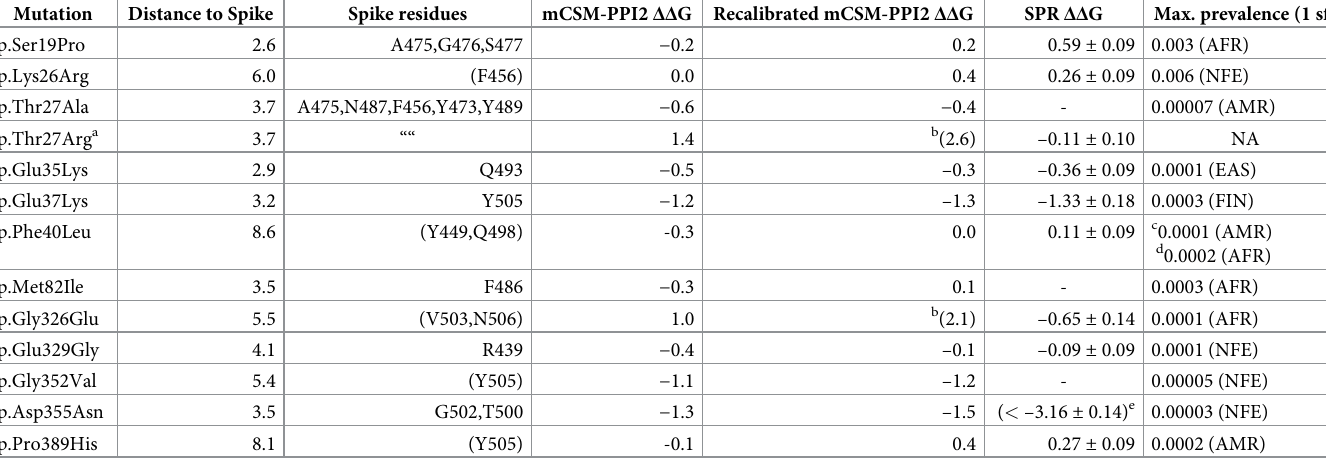
Table 1. Surface plasmon resonance derived ΔΔ G and mCSM-PPI2 [13] predictions for ACE2 mutants, including gnomAD [24] missense variants, at or near the ACE2 Spike interface. See S1 Table for mCSM-PPI2 predictions for all gnomAD variants in the ACE2 ectodomain. Mutation Distance to Spike